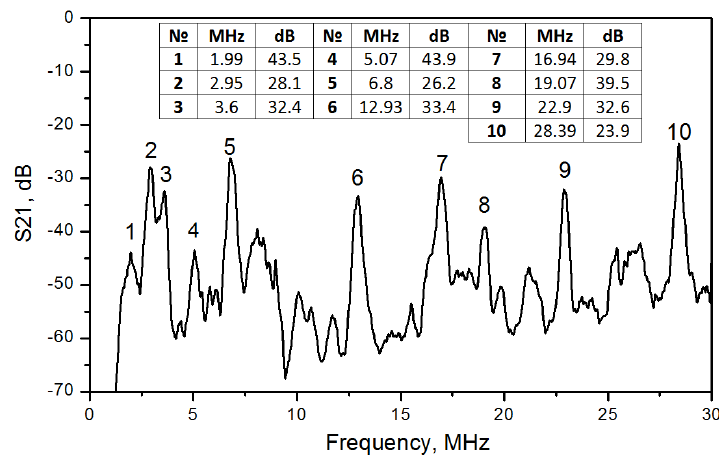
Fig. 5. Frequency dependence of the parameter S 21 of the delay line based on YX LiNbO3 plate. Work is supported by the grant #19-07-00145 from Russian Basic Research